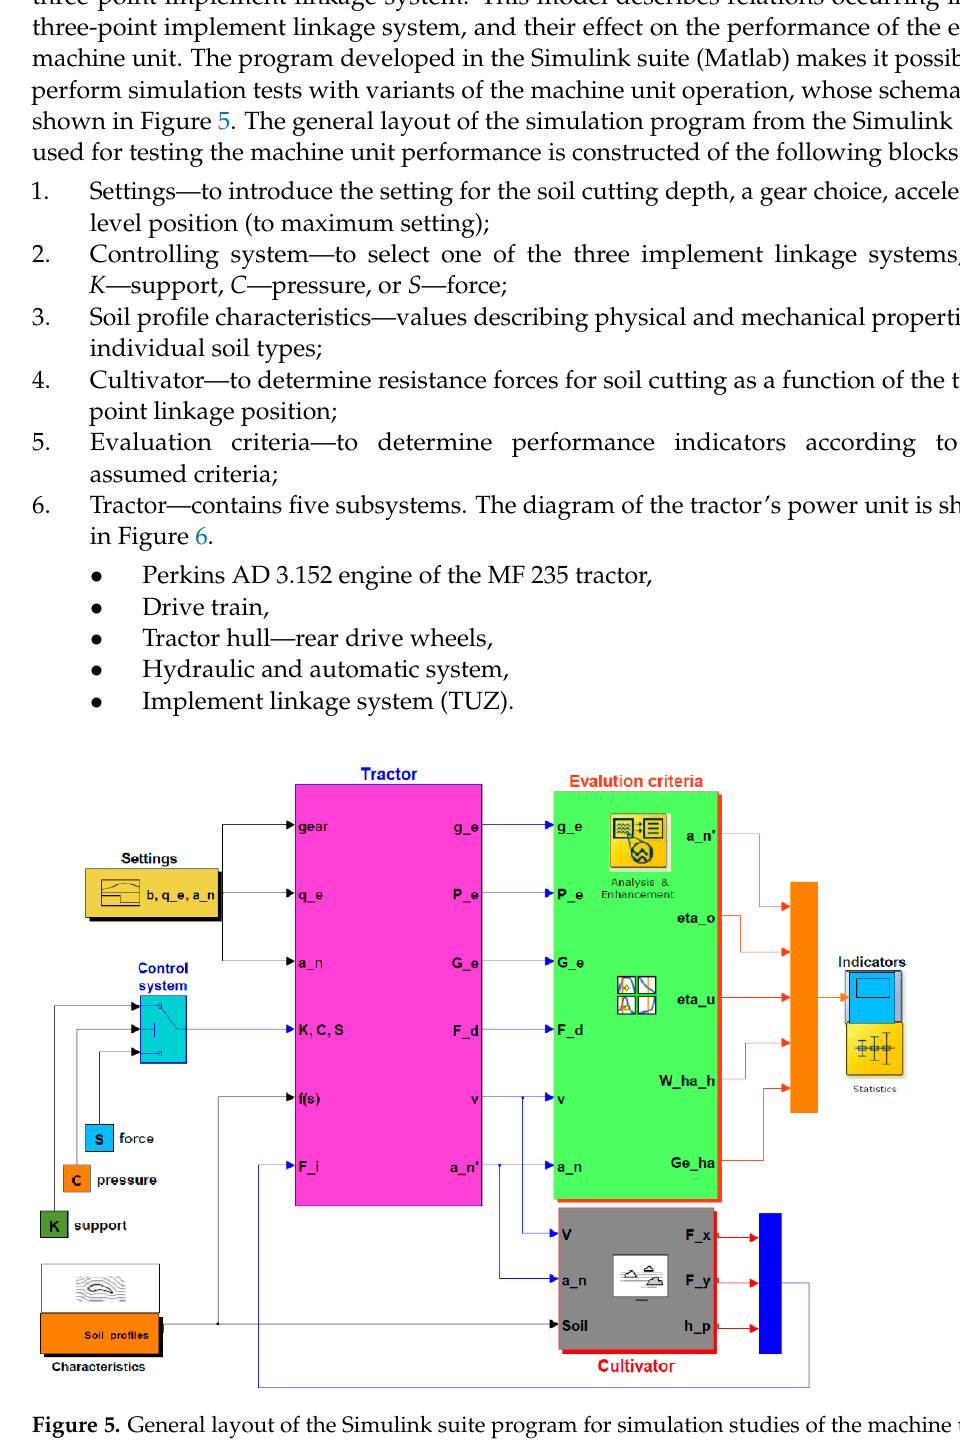
Figure 5. General layout of the Simulink suite program for simulation studies of the machine unit.